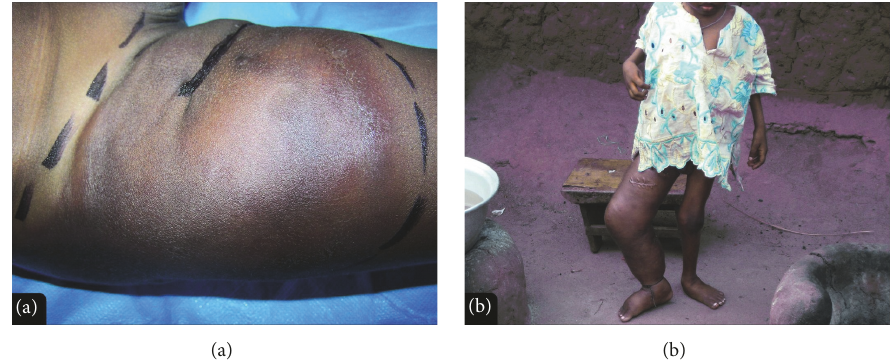
Figure 1: Clinical aspects (patient 3). (a) Lesion on R thigh, recurrence after initial resection. (b) The same patient three years later (a few months before his